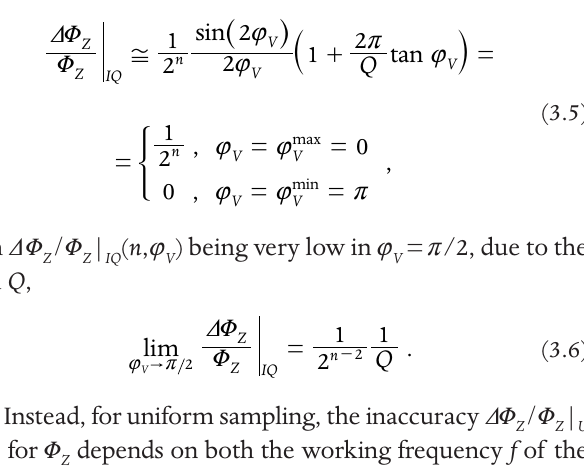
/ f ( f ) ≤ 0.1 and Dv / v ( f ) ≤ 0.1, for measurements performed on soil, with n =12, and on r r